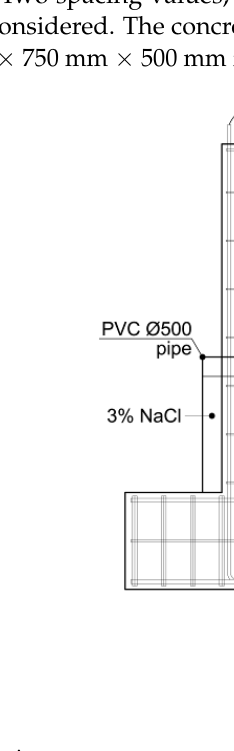
Figure 1. ( a ) Column geometry; ( b ) artificial corrosion process.